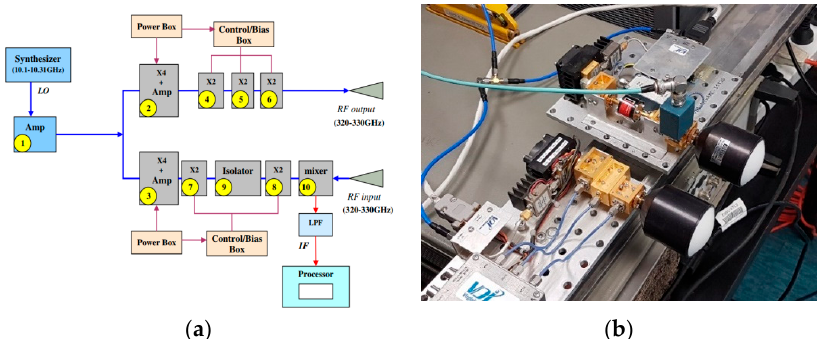
Figure 4. The 320–330 GHz Frequency-Modulated Continuous-Wave (FMCW) radar used in the experimental setup: ( a ) Block diagram and ( b ) Photo including transmitting and receiving antennas. Table 2. 320–330 GHz FMCW radar parameters.